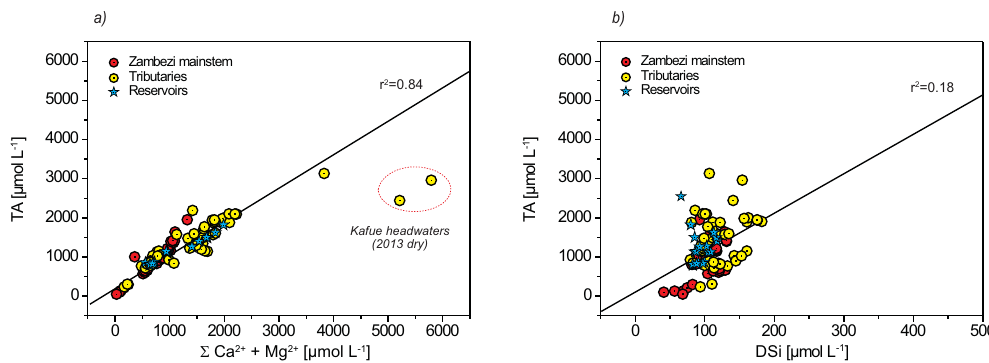
Figure 6. Relationships between the observed total alkalinity (TA) and (a) the sum of Ca 2 + and Mg 2 + , and (b) dissolved silica (DSi).